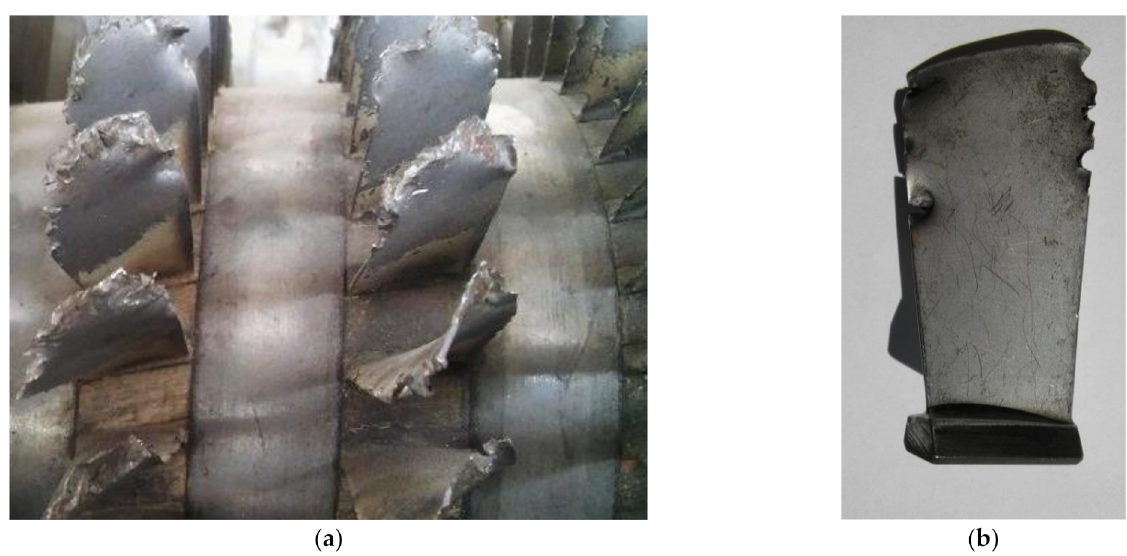
Figure 1. Photograph of a damaged compressor of a turbine engine ( a ) and a blade damaged by a collision with a foreign object ( b